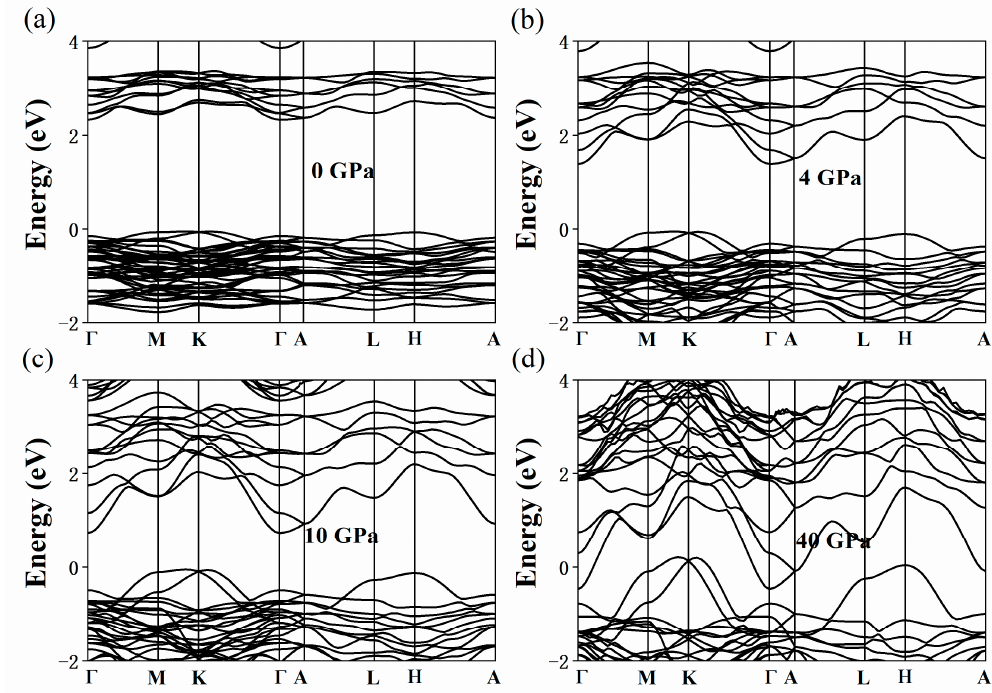
Figure 3. Calculated band structure of the Cs 3 Bi 2 I 9 perovskite under the pressures of 0 ( a ), 4 ( b ), 10 ( c ), and 40 GPa ( d ).